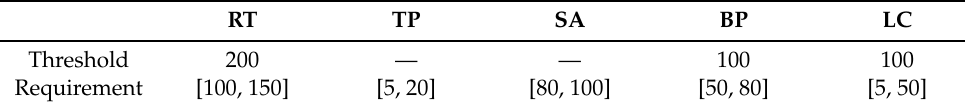
Table 3. User requirement.